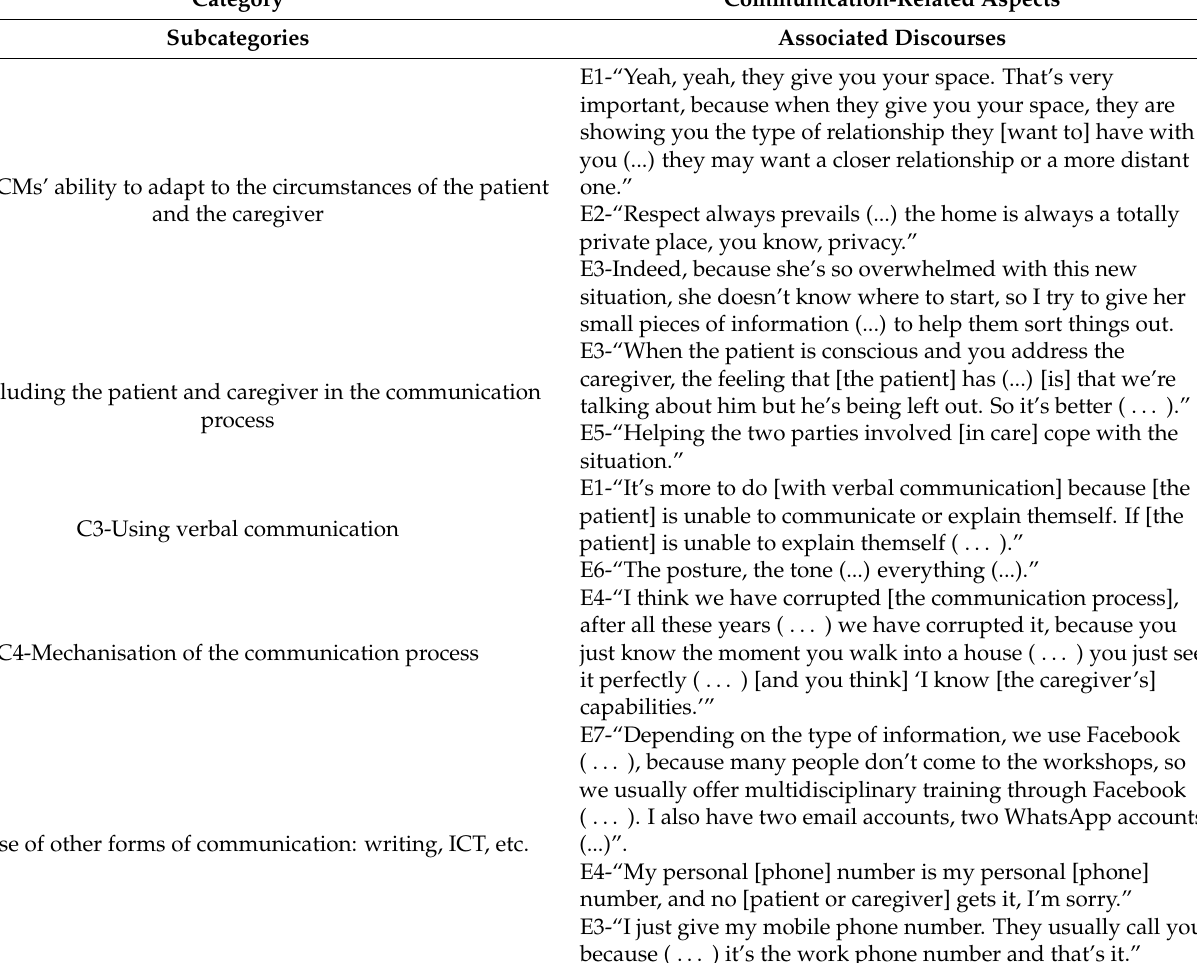
Table 2: In this table, the most relevant discourses, associated with the